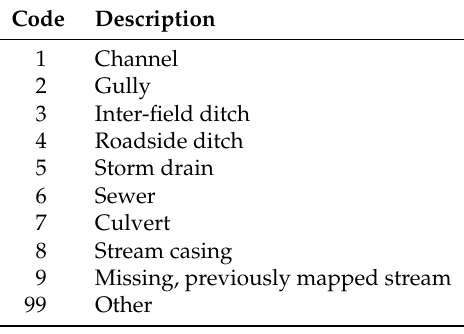
Table A6. Presence and absence of natural features as well as artificial point-shaped and linear